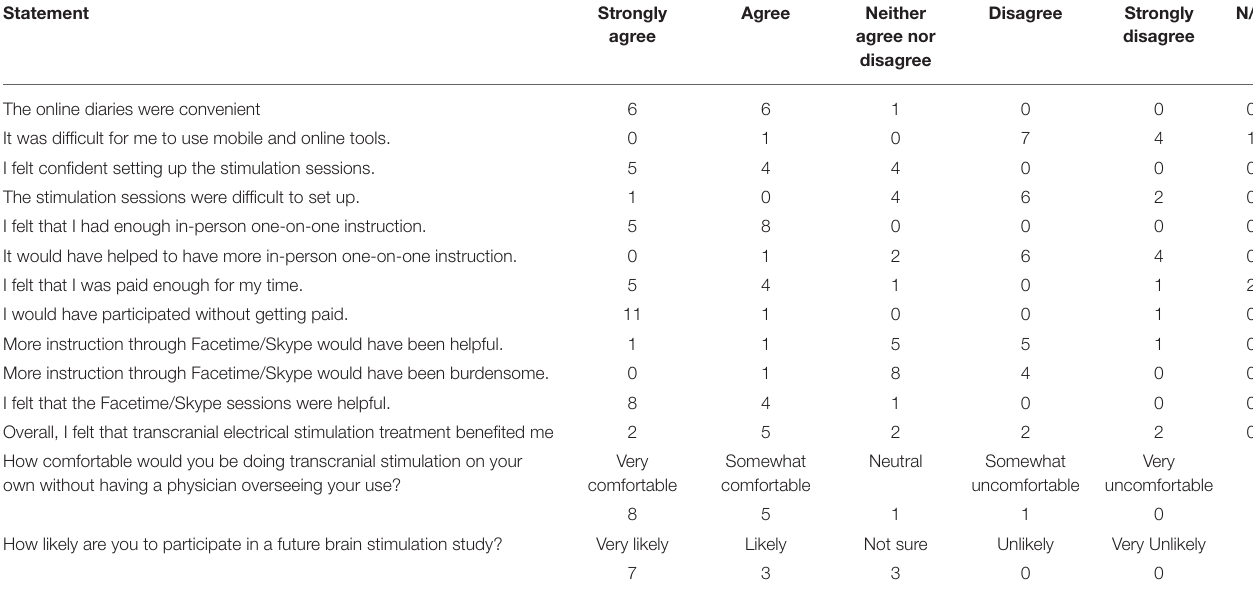
TABLE 2 | Anonymous participant feedback